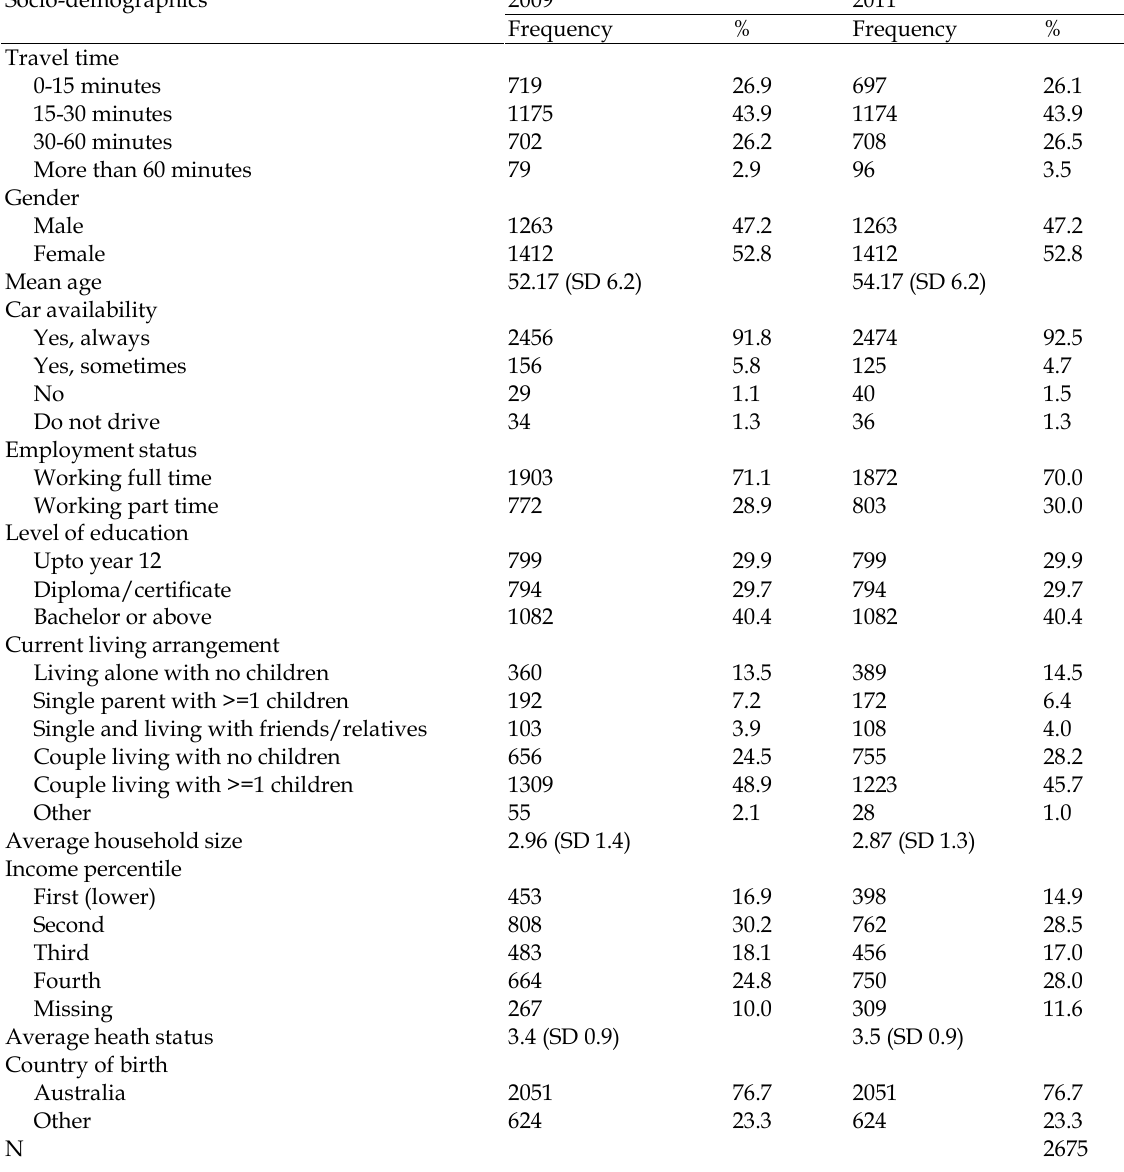
Table 2. Socio-economic characteristics of the respondents participated in the